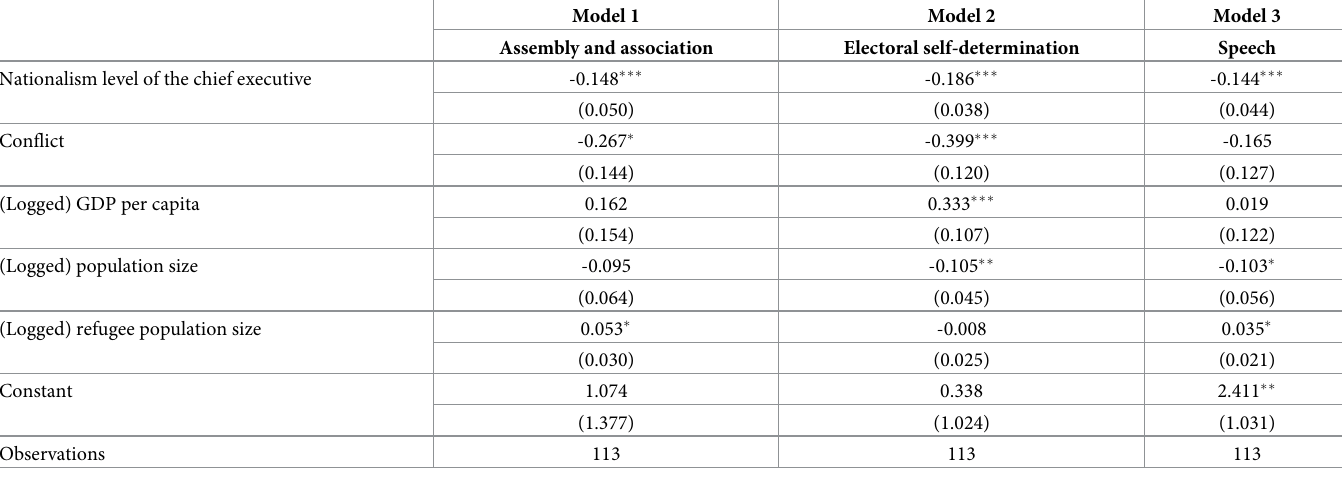
Table 1. PCSE estimates of CIRI scores in partial